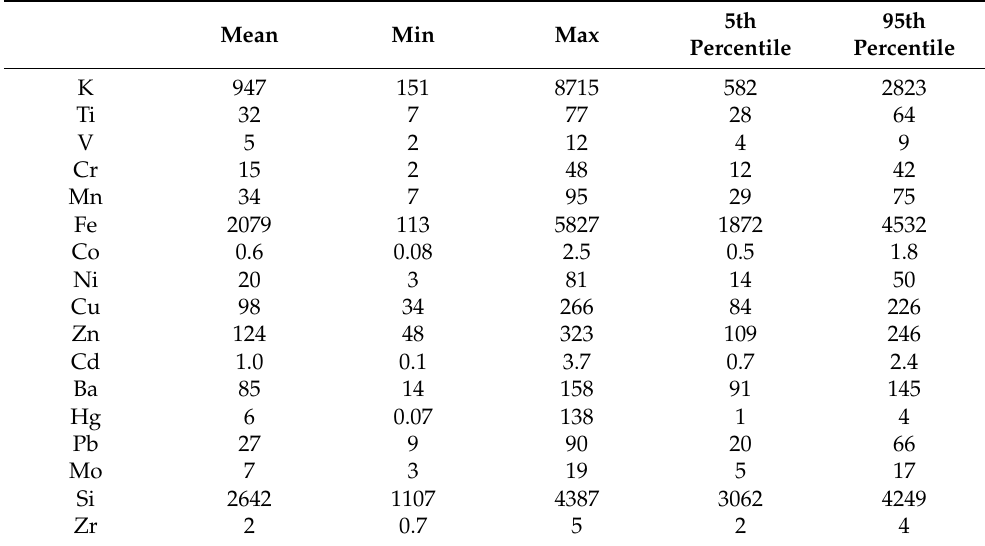
Table 4. Concentrations of mean, minimum, maximum, 5th percentile, 95th percentile of the analytes determined, expressed in ng m − 3 , for Grassi